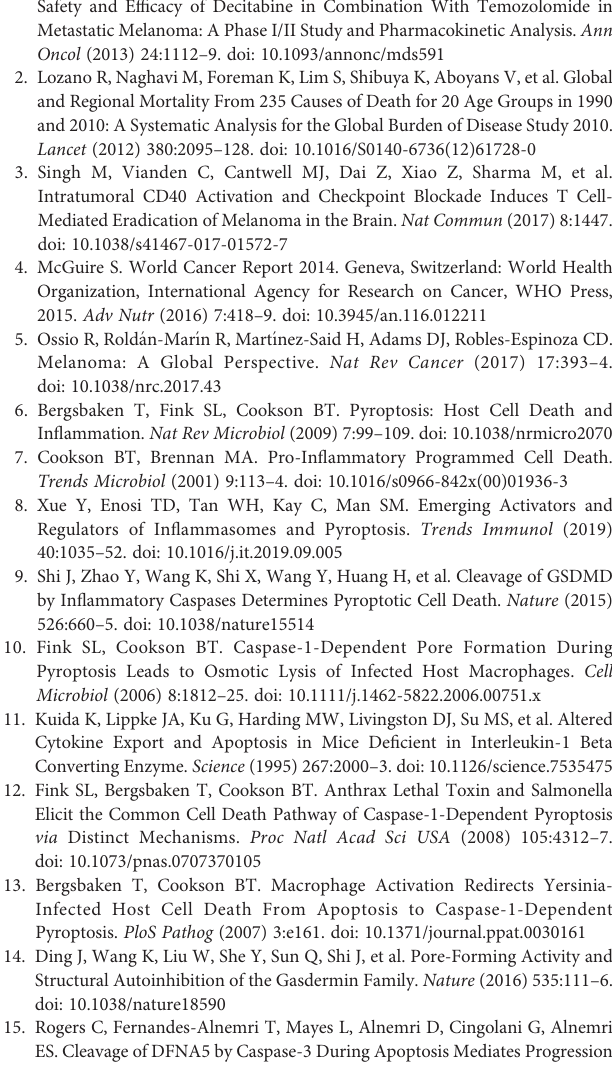
to Secondary Necrotic/Pyroptotic Cell Death. Nat Commun (2017) 8:14128. doi: